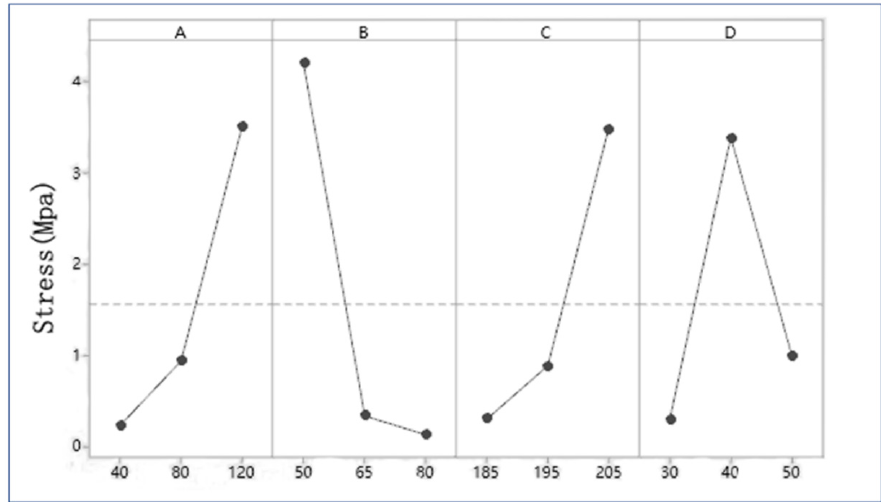
Figure 10. Effect of factors at different levels on stress: ( A ) Mesh. ( B ) Proportion. ( C ) Temperature. ( D ) Time.